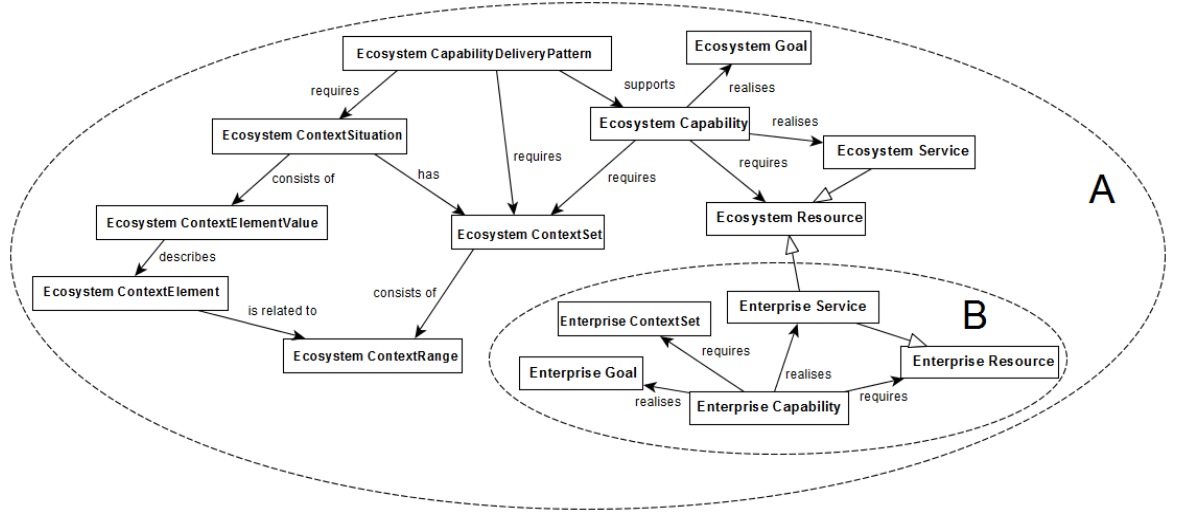
Figure 2. Extended Business Service Ecosystem